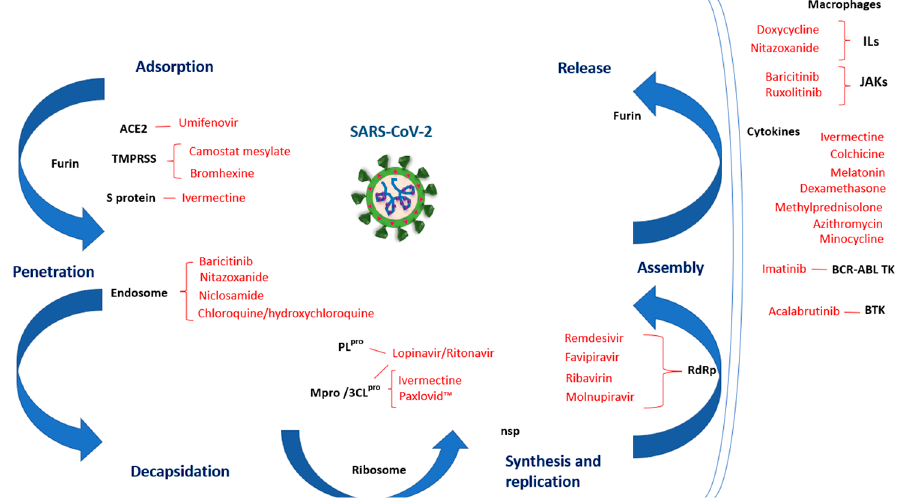
Figure 2. Drugs and their target within the different stages of the SARS-CoV-2 viral cycle.